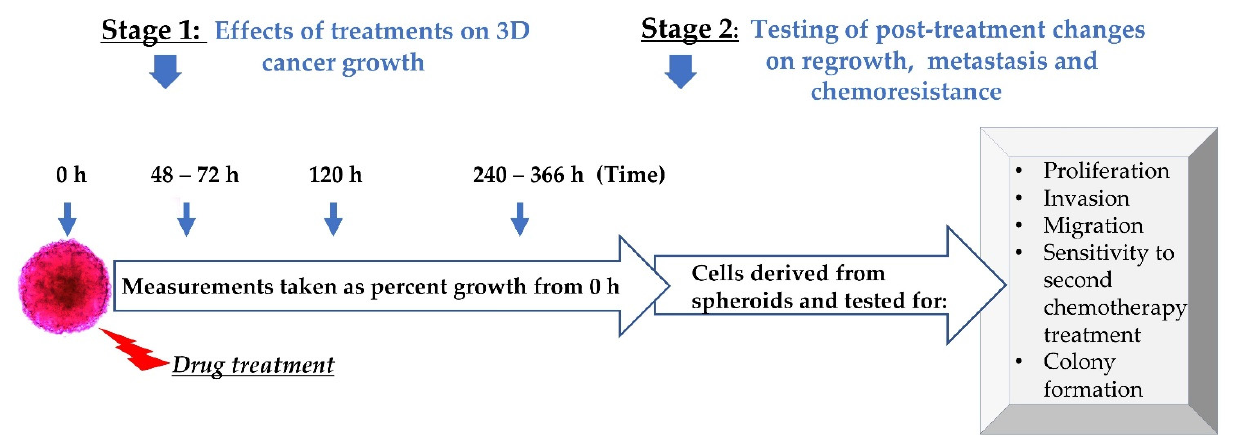
Figure 2. Experimental design. Following spheroid formation, epigenetic therapy or chemotherapy were administered in growth media. Measurements of spheroid growth were taken at specified time. Subsequently, 3D-derived cells from spheroids were evaluated for proliferation, invasion, migration, chemoresistance and colony formation.